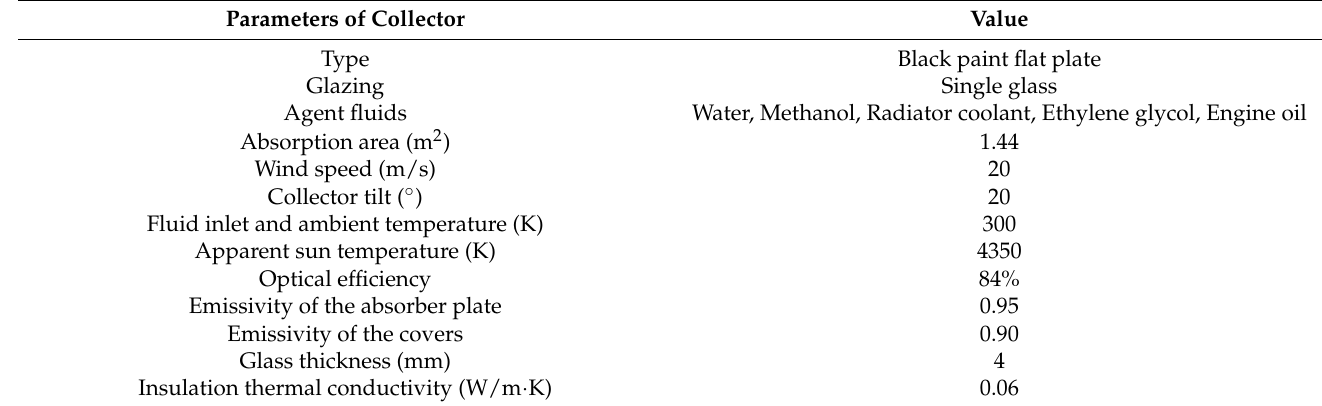
Table 1. Environmental and analysis conditions for the flat plate solar collector [47].